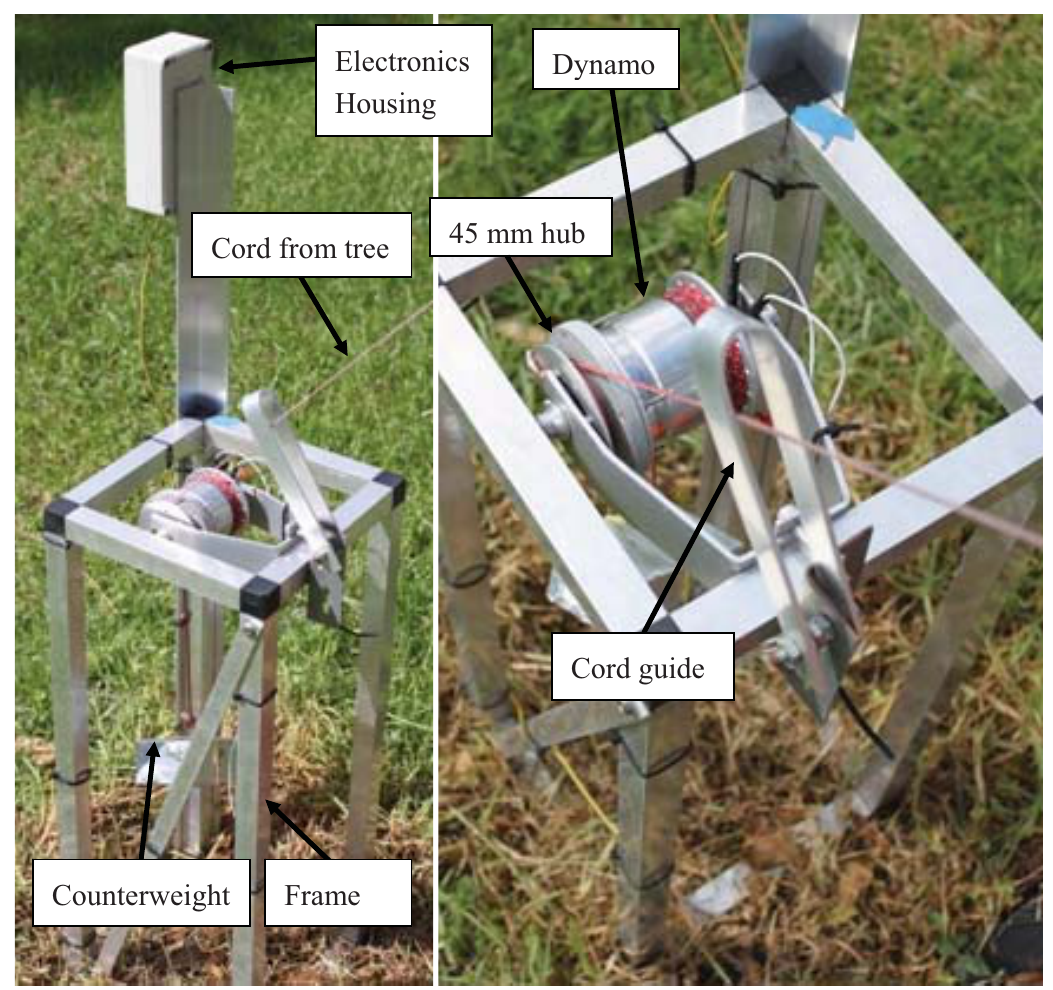
Figure 1. Tree movement energy harvesting